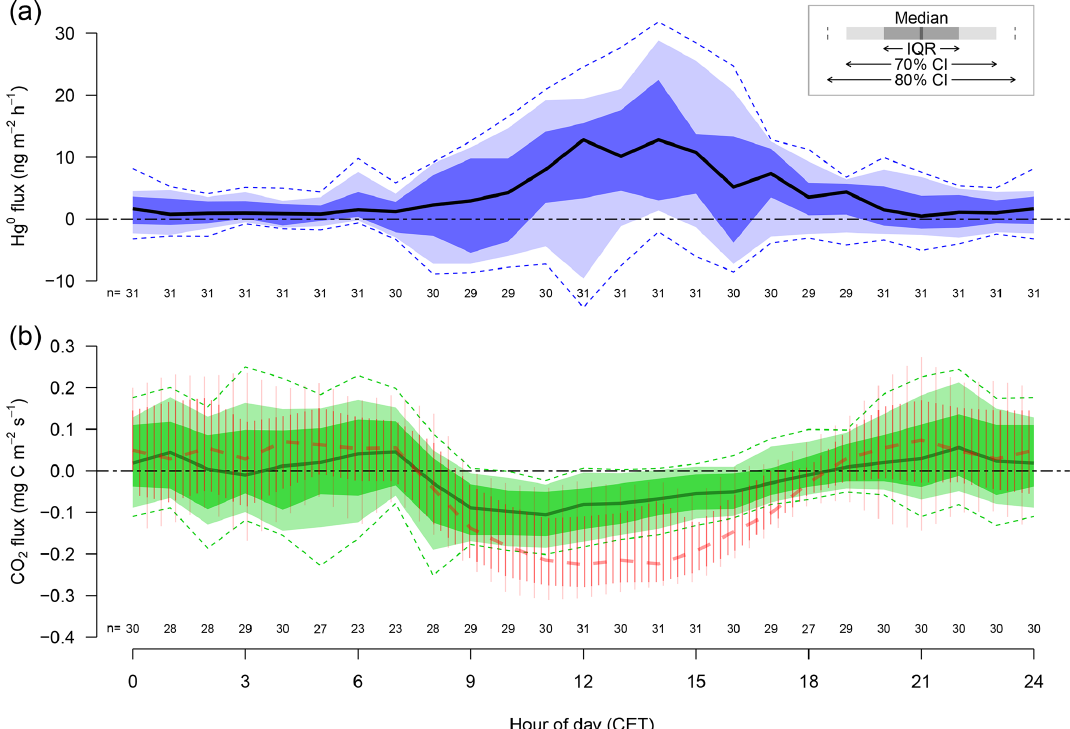
Figure 7. Hourly aggregated diel cycle of (a) Hg 0 fluxes and (b) simultaneously recorded CO 2 fluxes (bold green line) and fluxes measured in 2017 (red bold dashed line) for the same period. Each hour of the day represents the quantiles obtained from a 3h window centered on the respective hour of all technically valid observations. The bold lines represent median flux values. The interquartile range (IQR) is the range of the middle 50% of the data. The 70% and 80% confidence intervals (CI) and the number of measurements per hour ( n ) are given. The median CO 2 flux in 2017 is displayed (red bold dashed line). The IQR (red vertical lines) and the 70% CI (lighter vertical lines) are